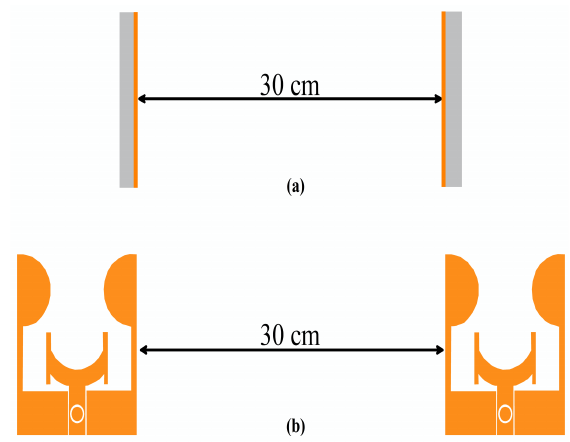
FIGURE 12. (a) Face-to-face configuration, (b) side-by-side configuration.